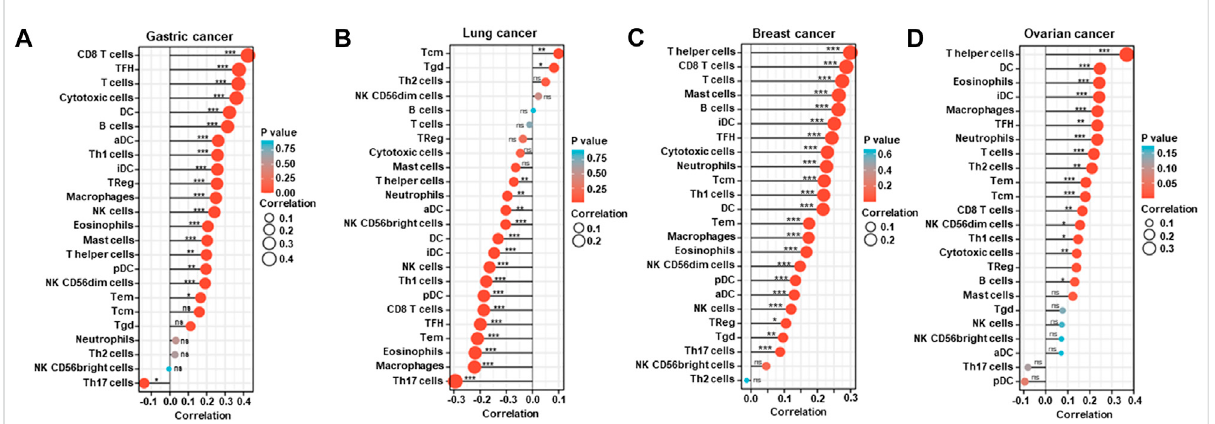
FIGO, federation of gynecology and obstetrics.